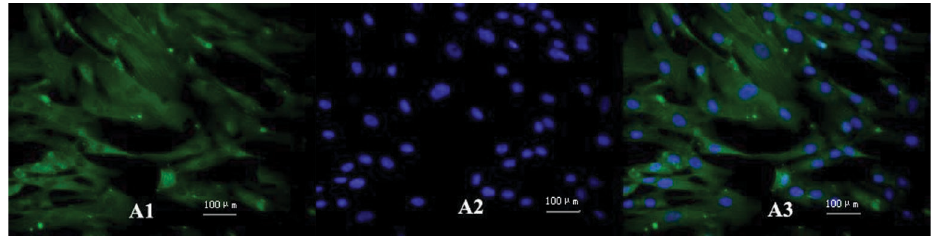
Figure 1. Identification of rat pulmonary arterial smooth muscle cells using a mouse anti-human smooth muscle a -actin monoclonal antibody. The images were acquired using an inverted phase contrast microscope (200 6 magnification). A1 , The cell cytoplasm was stained with FITC (green). A2 , The cell nuclei were stained with DAPI (blue). A3 , A1 merged with